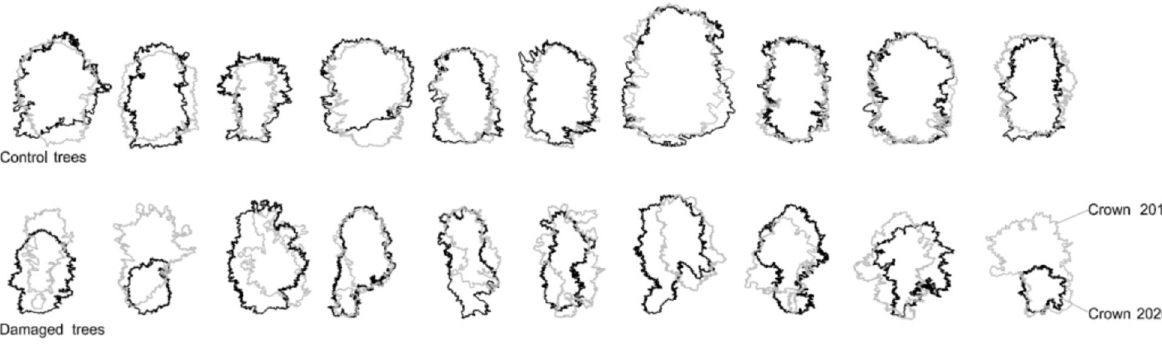
Fig 3. Comparison of tree silhouettes, 2016 and